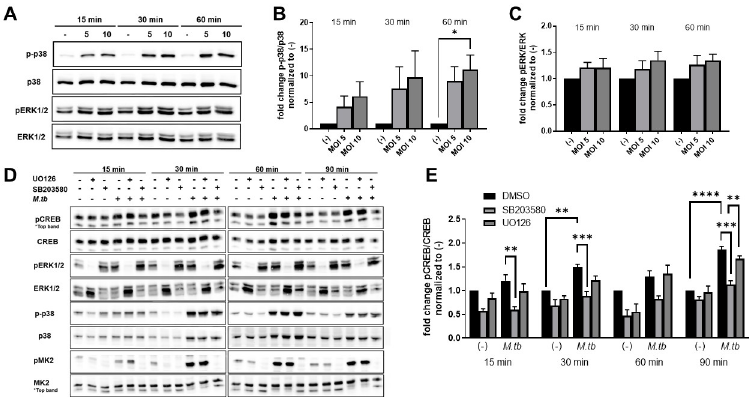
Fig 2. M . tb -induced CREB activation is p38-dependent and ERK-independent. A) MDMs were infected with M . tb H 37 R v by synchronized phagocytosis at the indicated MOI. WB was performed to detect levels of phosphorylated and total p38 and ERK1/2 protein at the time points specified. Data are representative of n = 4 donors. B,C) Densitometry of phosphorylated protein normalized to total protein. Data are cumulative ± SEM of n = 4 donors. One-way ANOVA with Tukey’s post-test. D-E) MDMs were pretreated with SB203580 or UO126 for 60 min prior to infection with M . tb H 37 R v at MOI 10. D) WB was performed to detect levels of phosphorylated and total levels of CREB, p38, ERK1/2, and MK2 protein at the specified time points. Data are representative of n = 4 donors. E) Densitometry of phosphorylated protein normalized to total protein. Data are cumulative ± SEM of n = 4 donors. One-way ANOVA with Tukey’s post- test; * p < 0.05, ** p < 0.01, *** p < 0.001, **** p <